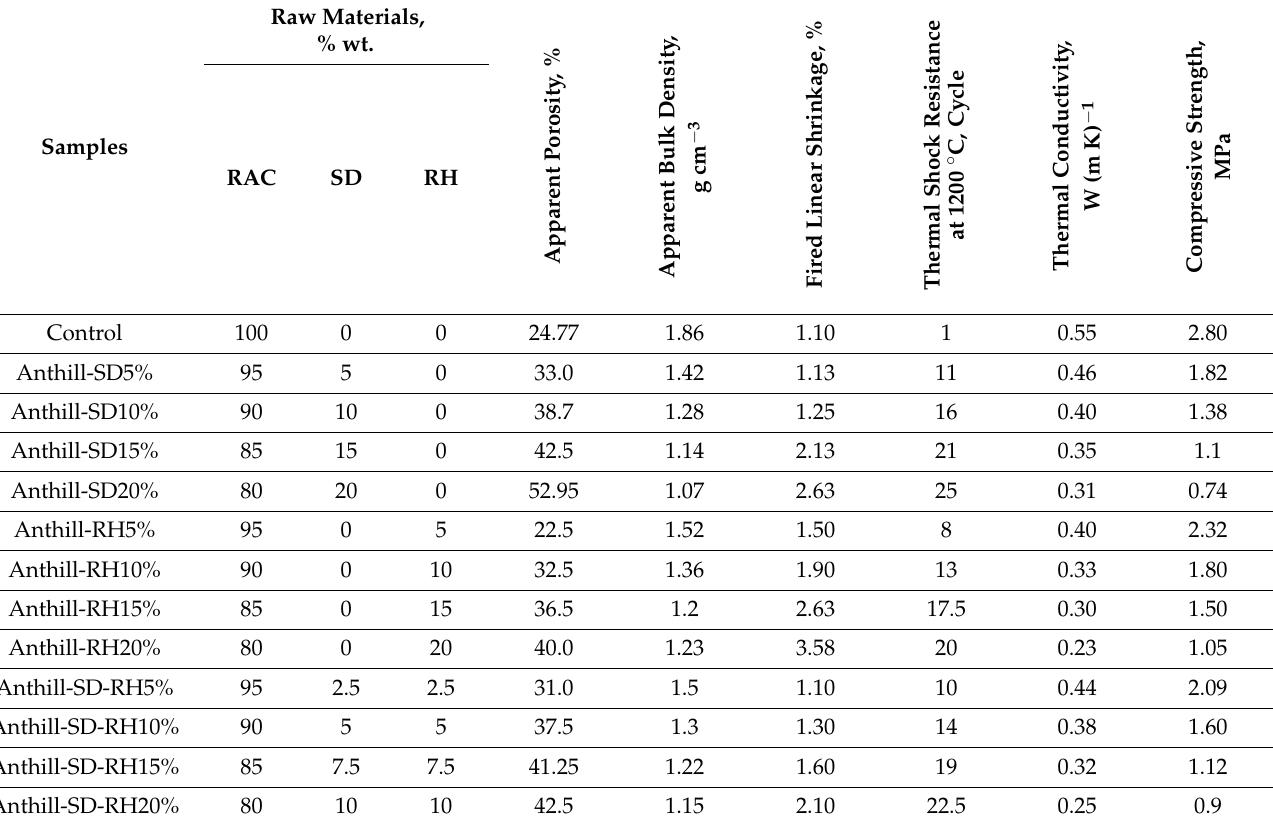
Table 7. Composition and Properties of Ghanaian Red Anthill Clay-Based with SD/RH additives. Thermal Insulating Materials. Data from